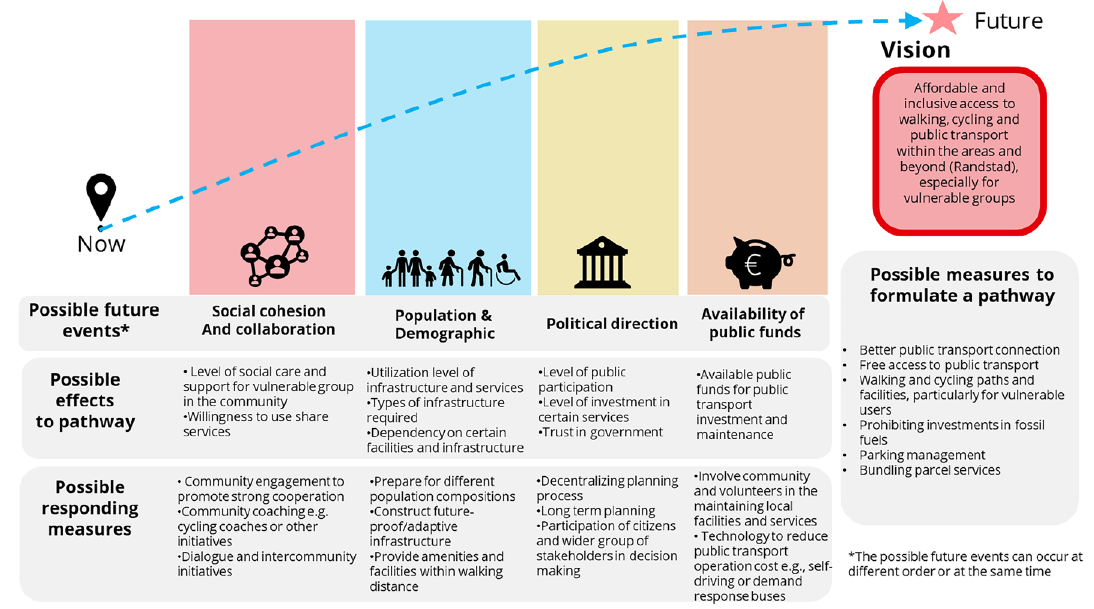
Figure 4. A summarised outcomes of the stakeholder